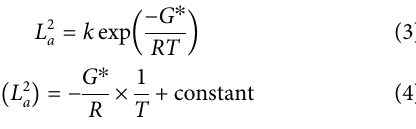
Frontiers in Materials |